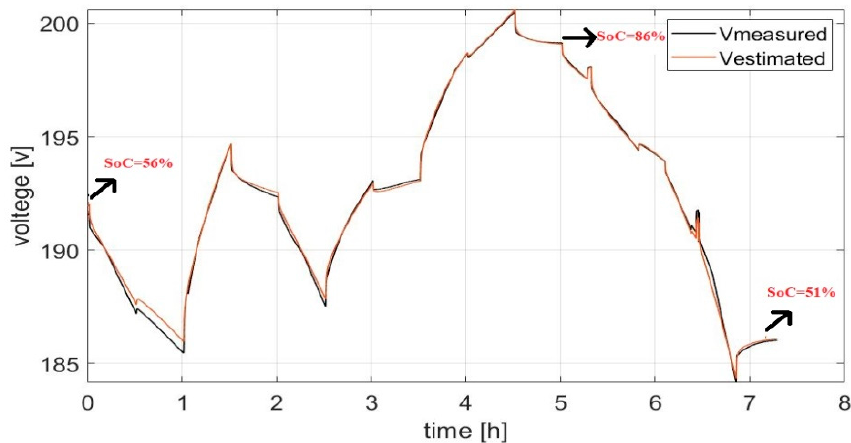
Figure 24. Measured vs estimated terminal voltage.